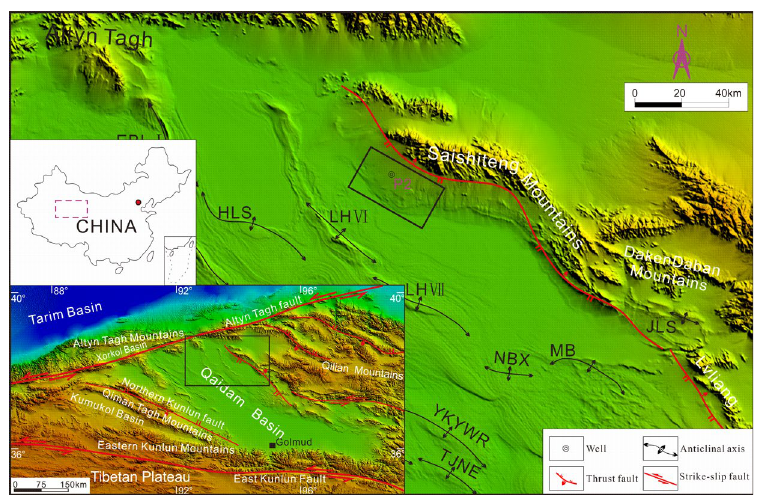
Figure 1. Structural location of the Pingtai area in the northern margin of the Qaidam